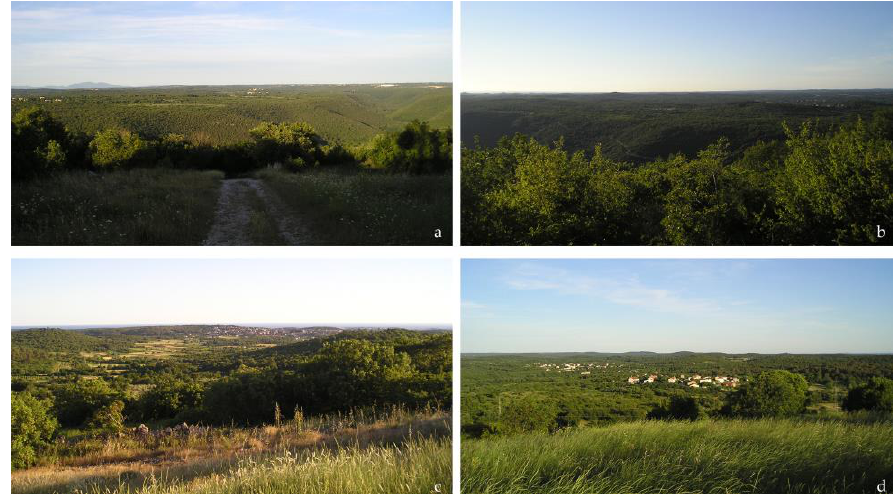
Figure 9. Views from the viewpoint of St. Martin to the: ( a ) east; ( b ) north; ( c ) southwest; and ( d ) south.